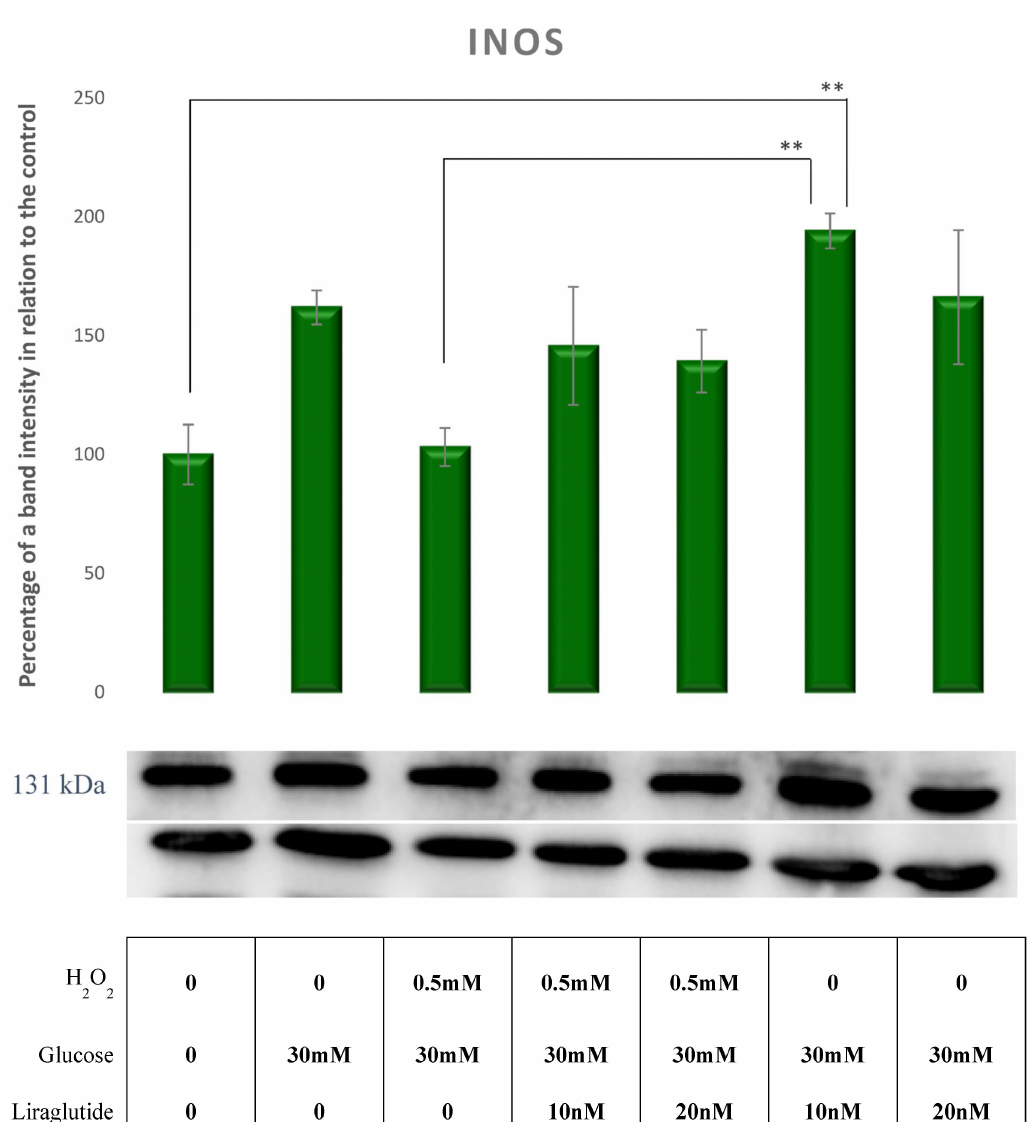
Figure 11. Protein expression in the LLC-PK1-treated cell line (control vs. HG30 and HG30/H 2 O 2 ; HG30 vs. HG30/Lira10 and HG30/Lira 20; HG30/H 2 O 2 vs. HG30/H 2 O 2 /Lira10 and HG30/H 2 O 2 /Lira 20) determined by Western blot. Glyceraldehyde 3-phosphate dehydrogenase (GAPDH) was used as an internal control. The data are shown as the means ± SD (standard deviation) from three independent biological replicates. One-way ANOVA F(6,20) = 4.241, p = 1.218 × 10 − 2 with Tukey HSD post hoc test; ** p < 0.01. Values underneath the x axis represent the amount of compound added in the experiment, and 0 represents that the compound was not added. Protein expression, pig proximal tubule cell line (LLC-PK1), HG (1.5 mM, 30 mM), H 2 O 2 (0.5 mM), Liraglutide (10 nM, 20 nM). The protein levels of pSTAT3 in HG30- and HG30/H 2 O 2 -treated cells increased rela- tive to the control group ( p = NS). The treatment with HG30/H 2 O 2 /Lira10 significantly increased the pSTAT3 levels compared to controls ( p < 0.01), as shown in Figure